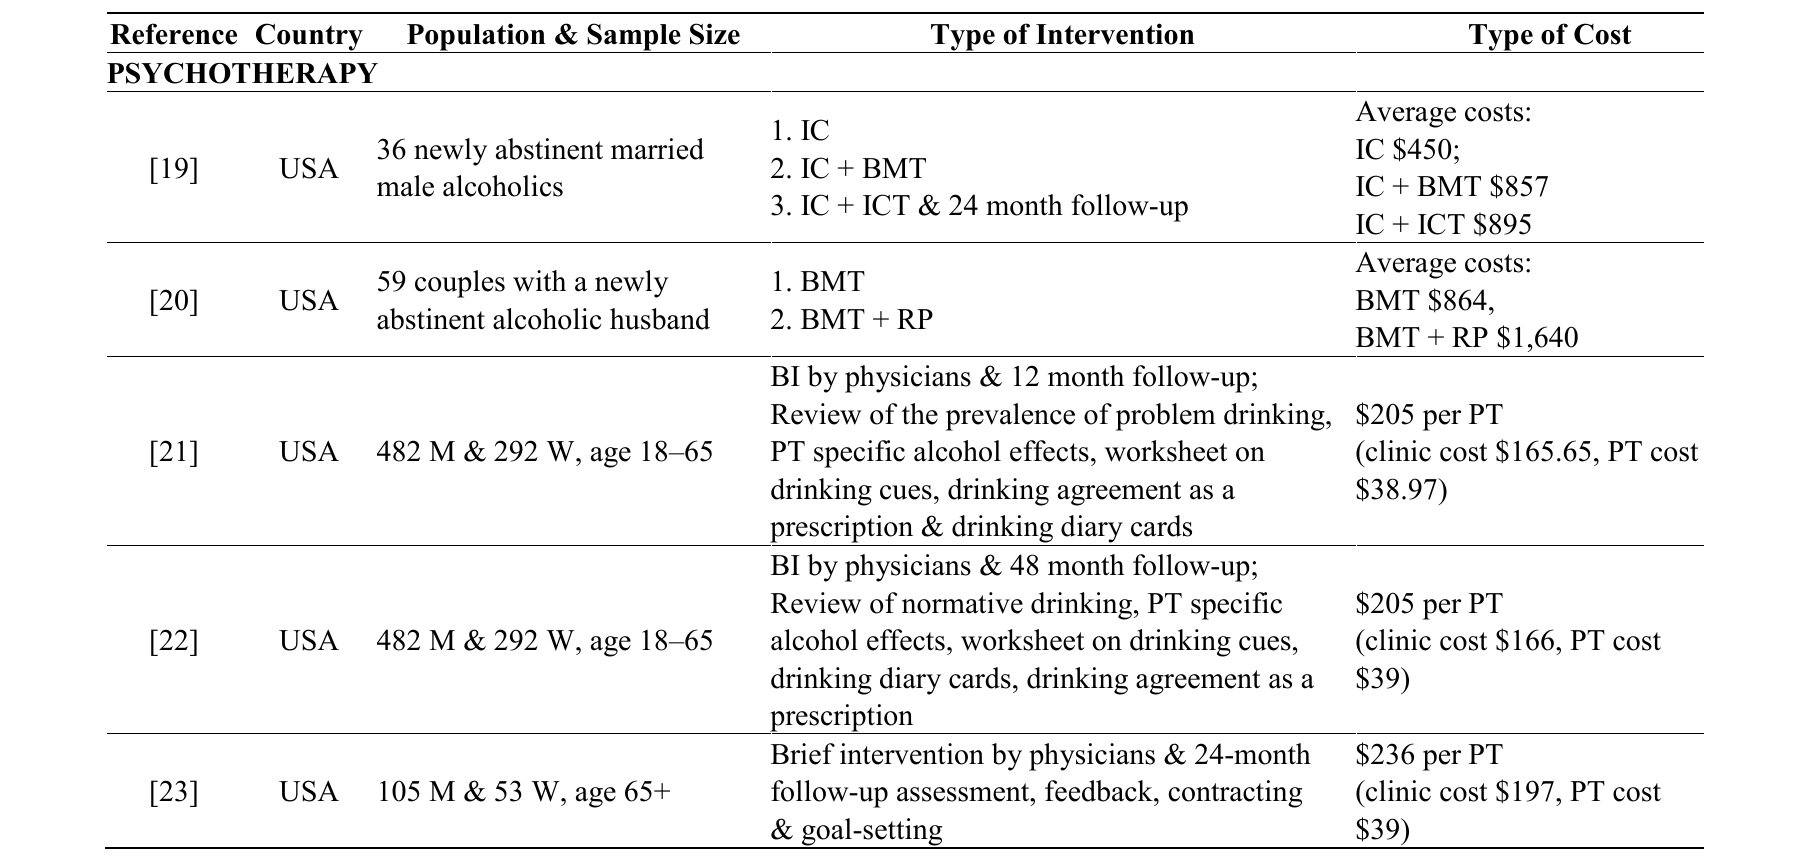
Table 1. Summary of cost-benefit studies on alcohol dependence